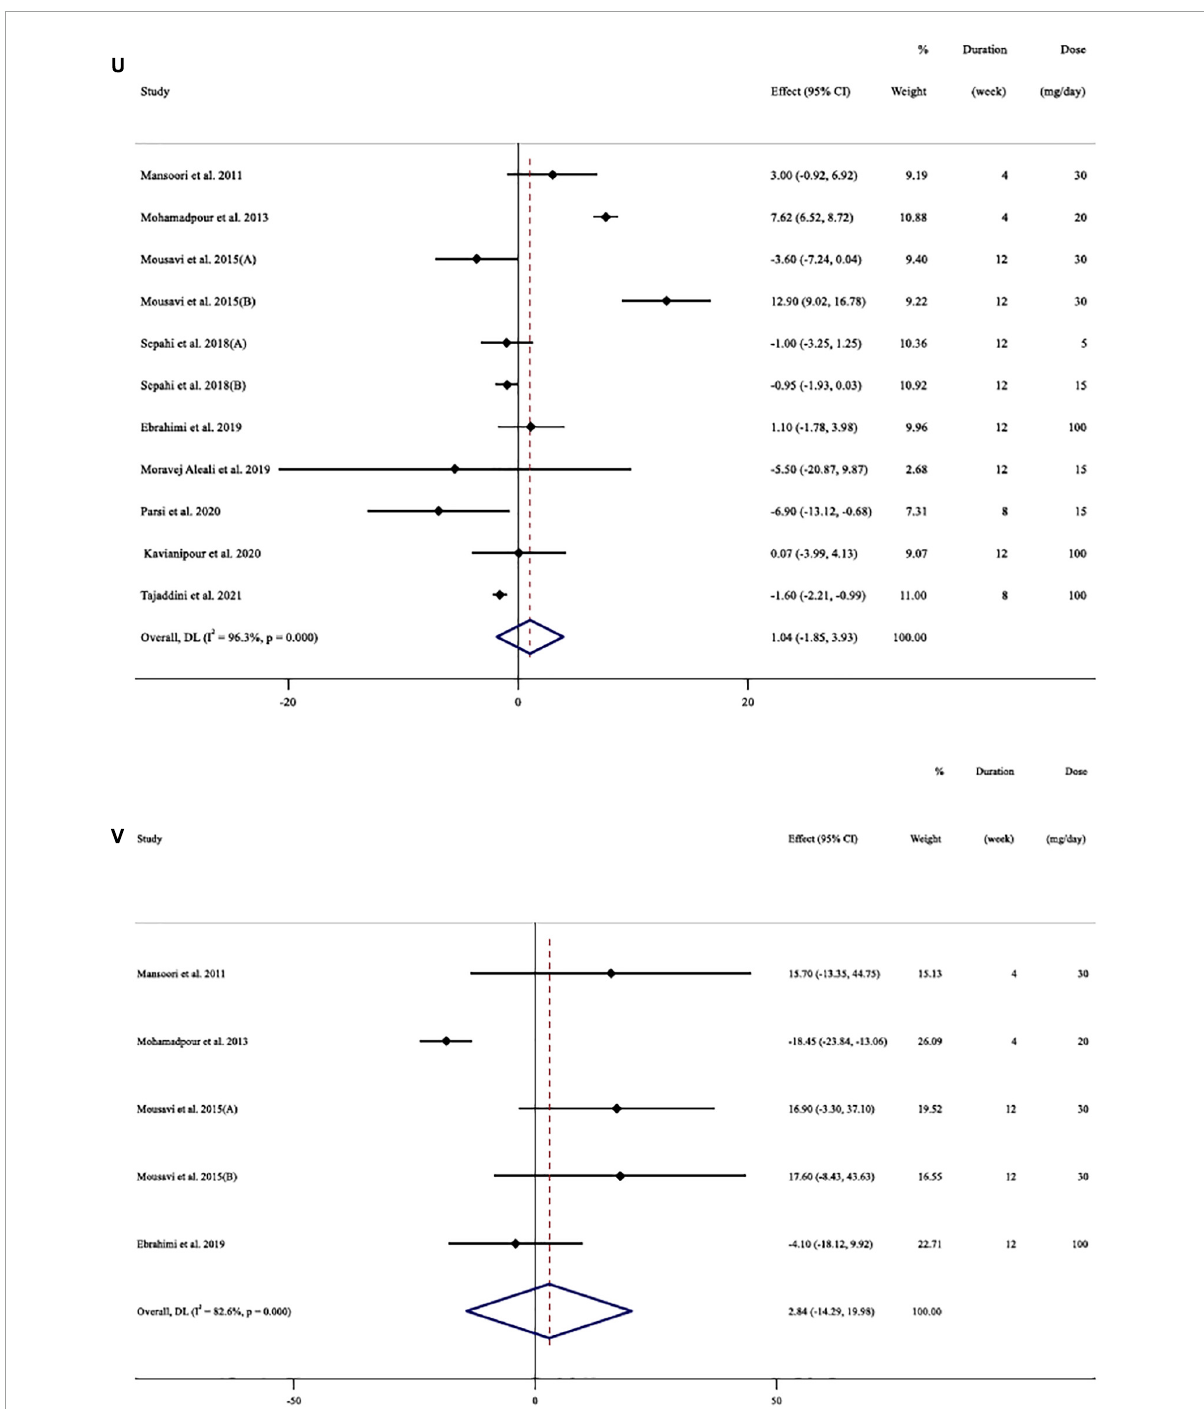
FIGURE2 Forest plot detailing weighted mean difference and 95% confidence intervals (CIs) for the effect of saffron consumption on (A) TG (mg/dl); (B) TC (mg/dl); (C) LDL (mg/dl); (D) HDL (mg/dl); (E) FBG (mg/dl); (F) Insulin (miu/ml); (G) HbA1c (%); (H) HOMA-IR; (I) SBP (mmHg); (J) DBP (mmHg); (K) CRP (mg/l); (L) ; IL-6 (pg/ml); (M) TNF- α (pg/ml); (N) weight (kg); (O) BMI (kg/m 2 ); (P) WC (cm); (Q) FM (%); (R) MDA (uM/L); (S) TAC (mM/L); (T) ALT (U/L); (U) AST (U/L) and (V) ALP (U/L). TG, triglyceride; TC, total cholesterol; LDL, low-density lipoprotein; HDL, high-density lipoprotein; FBG, fasting blood glucose; HOMA-IR, homeostasis model assessment for insulin resistance; HbA1C, hemoglobin A1C; CRP, C-reactive protein; IL-6, interleukin 6; TNF- α , tumor necrosis factor; TAC, total antioxidant capacity; BMI, body mass index; WC, waist circumference; FM, fat mass; ALT, alanine transaminase; AST, aspartate transaminase; ALP, alkaline phosphatase; MDA, malondialdehyde ; SBP, systolic blood pressure; DBP, diastolic blood pressure; CI, confidence interval; WMD, weighted mean